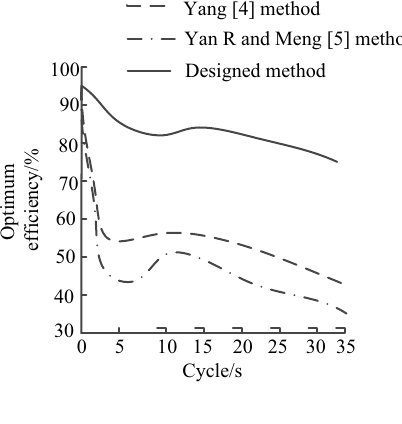
Figure 4: Comparison of three models.